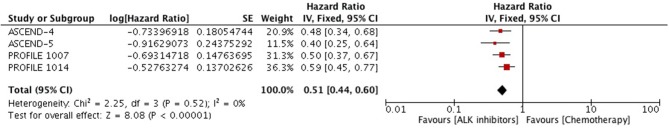
Forest plot of meta-analysis of the time to deterioration with respect to a composite end point of three symptoms–cough, dyspnea or chest pain showing comparison of ALK inhibitors to chemotherapy in ALK positive NSCLC.